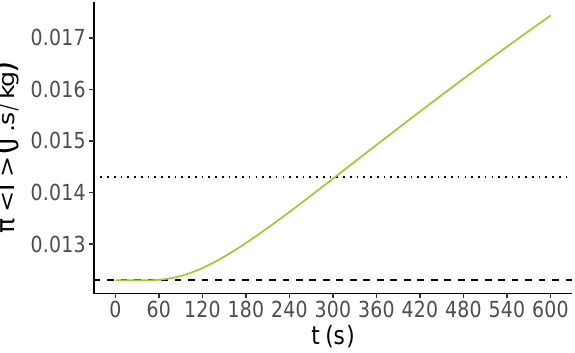
Figure 2. π (cid:104) I (cid:105) versus time (green line), see Equation (10). The median value given in Table 2 is indicated by the horizontal dashed line, while the average value found in Ref. [29] is shown by the dotted line.